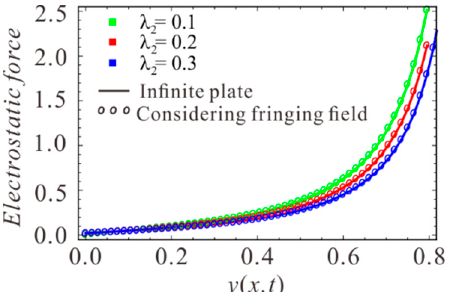
Figure 2. The comparisons of electrostatic forces under different λ 2 at λ 1 = 0. Solid lines show solution of the infinite plate model and circle show solution considering the fringing fields.